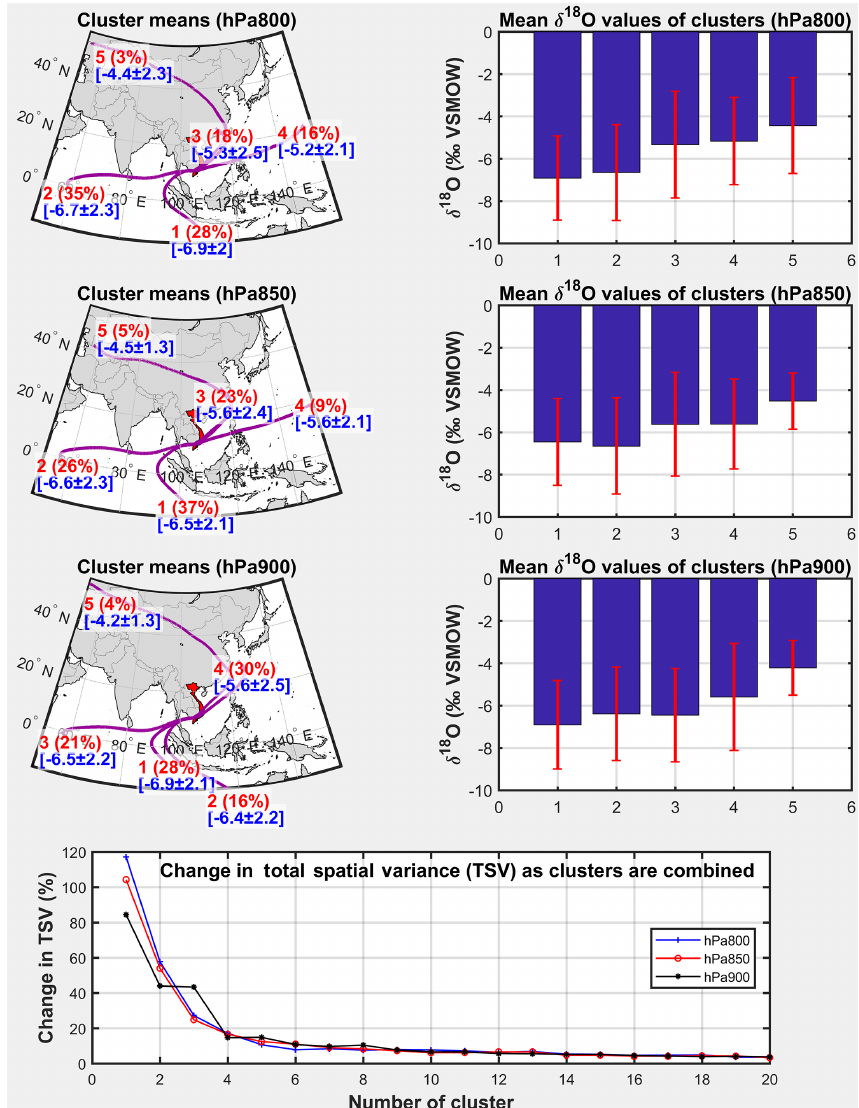
Figure 6. Spatial distribution of vapor trajectories (cluster means) for precipitation days at An Long for three barometric surfaces (800, 850, 900hPa) between June 2014 and December 2015, and change in total spatial variance (TVS) for different cluster numbers. The TSV was used to identify the optimum number of clusters (here 5 clusters). Red numbers indicate the cluster number (1–5) and the percent of all trajectories assigned to each of the five clusters. Blue numbers and bar charts indicate the mean δ 18 O values for each cluster plus/minus the standard deviation of each